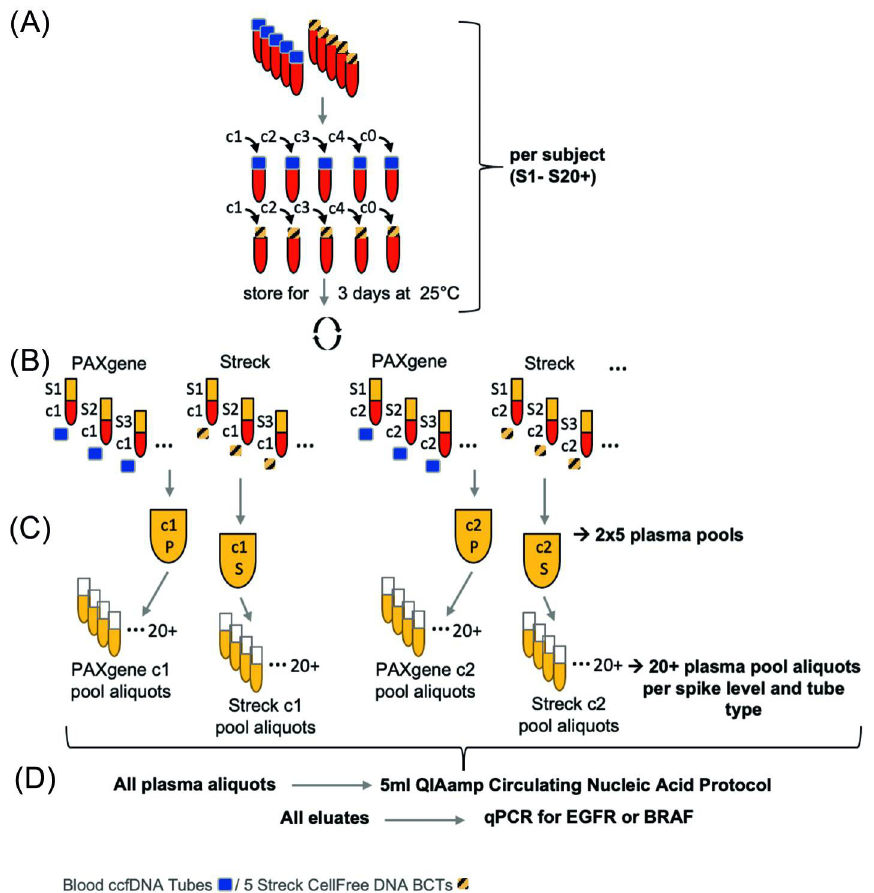
Fig 1. Flow chart of the experimental setup. (A) Blood collection: Blood from at least 20 subjects per experiment (S1- S20+) was drawn in random order with 10 replicate tubes per subject divided in 5 PAXgene Blood ccfDNA Tubes and 5 Streck CellFree DNA BCTs. Only completely drawn tubes (10ml blood) were included. (B) Spike-in & storage: 4 concentrations (c1-c4) of spike-in material was pipetted in the blood directly after draw, The fifth tube was left un- spiked as negative control (c0). All tubes were stored for 3 days at 25˚C. (C) Plasma-generation & -pooling: Plasma was separated with a centrifugation protocol recommended by the tube suppliers. Complete plasma was removed from each tube. All plasma aliquots of one spike-level within one tube type were pooled. Plasma volume was measured of each pool and calculation of tube equivalent aliquot volume was done. (D) ccfDNA isolation, PCR assays and LOD calculation: Plasma pools were split in 20+ aliquots with a tube equivalent volume each. CcfDNA was isolated from each aliquot using the QIAamp Circulating Nucleic Acid Kit and the 5ml plasma input protocol. For eluate QC all eluates were analyzed by Qubit and Bioanalyzer measurements. QPCR assays targeting the spiked EGFR or BRAF gene mutations were run with all eluates. Probit based calculation of the LOD95 values were carried out for all qPCR (sub-)